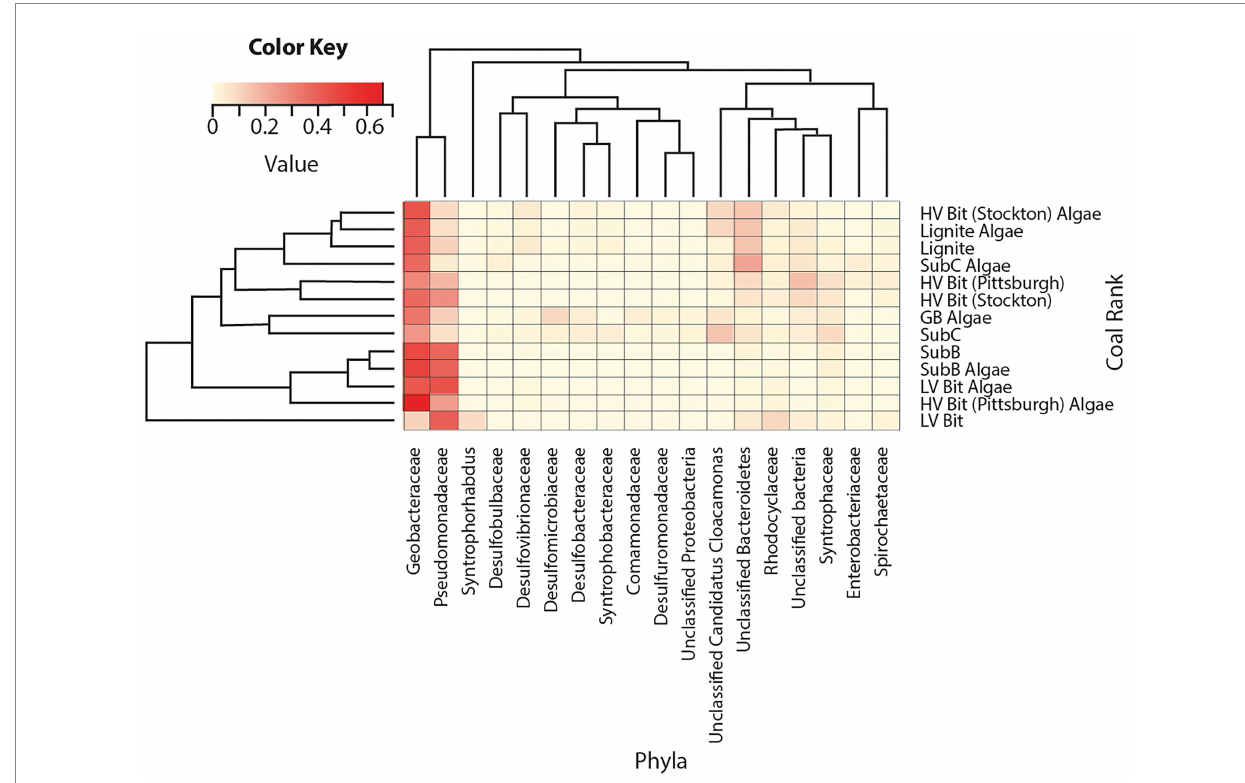
FIGURE 4 Heatmap of bacterial relative abundance of OTUs combined by phylotype. Phylotypes without a relative abundance of 2.5% in at least one sample were